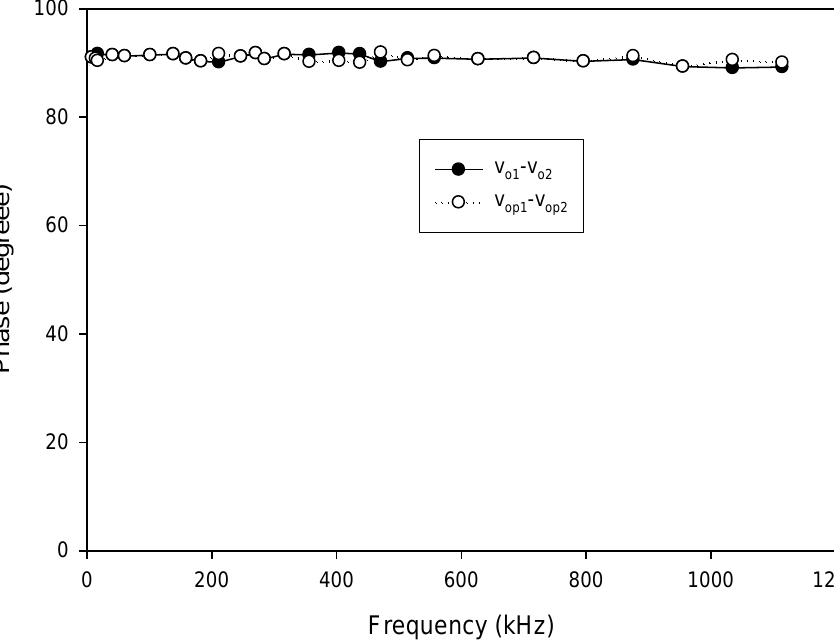
Figure 13. Phase difference of the quadrature output voltage.